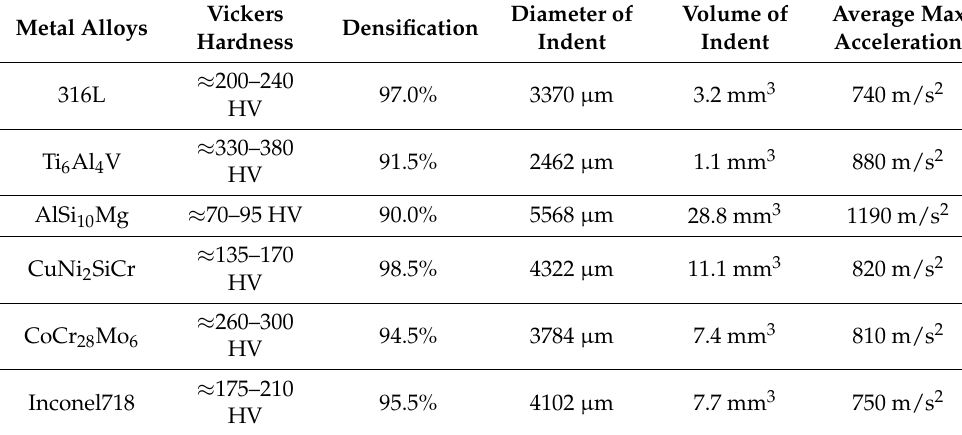
Table 2. Metallic alloys characterization: Vickers hardness, densification after SPSing, diameter and volume of deformation indent formed, and average maximum acceleration as result of impact